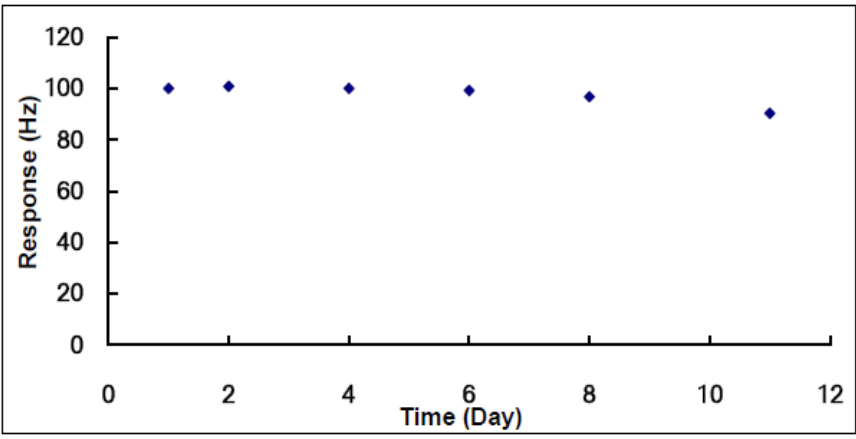
Figure 8. Responses of a nanowire ZnO predefined concentration of 0.54 ppm DMMP in nitrogen gas during 10